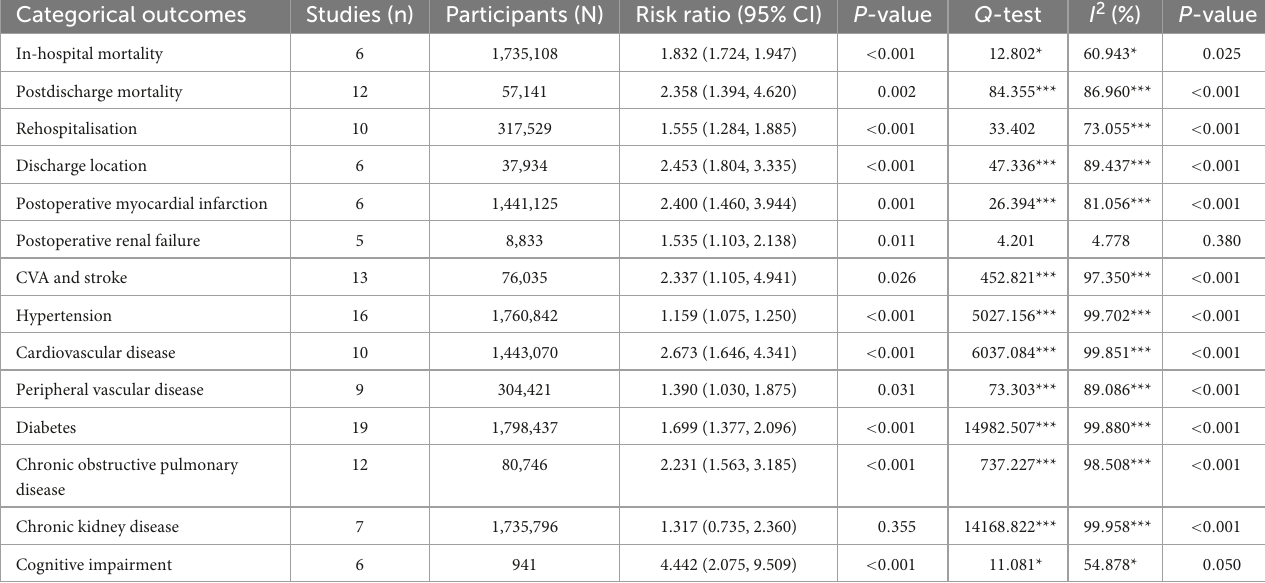
TABLE 2 Standardized mean difference and risk ratio on categorical outcomes. Categorical outcomes